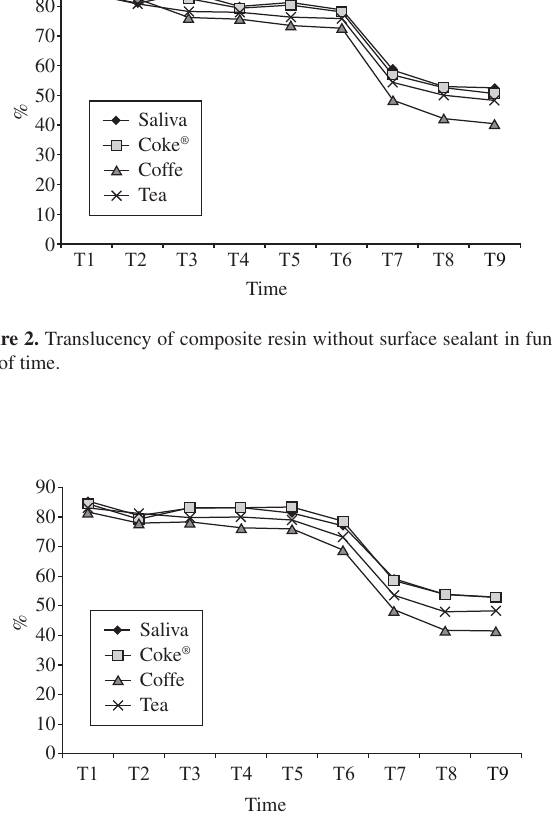
Figure 3. Translucency of composite resin with surface sealant in function of